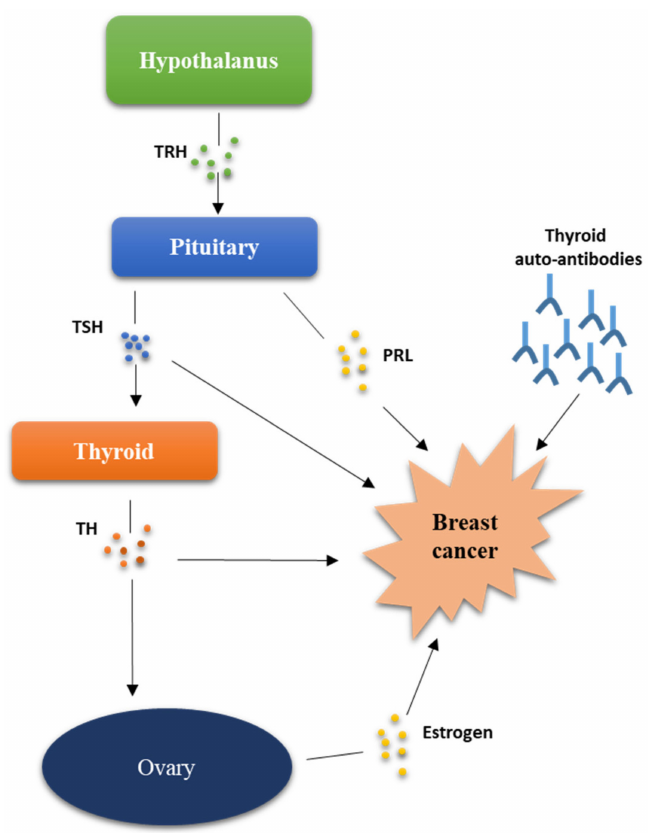
Figure 2. Influence of the hypothalamic–pituitary–thyroid axis on breast cancer progression. Thyrotropin-releasing hormone (TRH); thyrotropin (TSH); prolactin (PRL); thyroid hormone